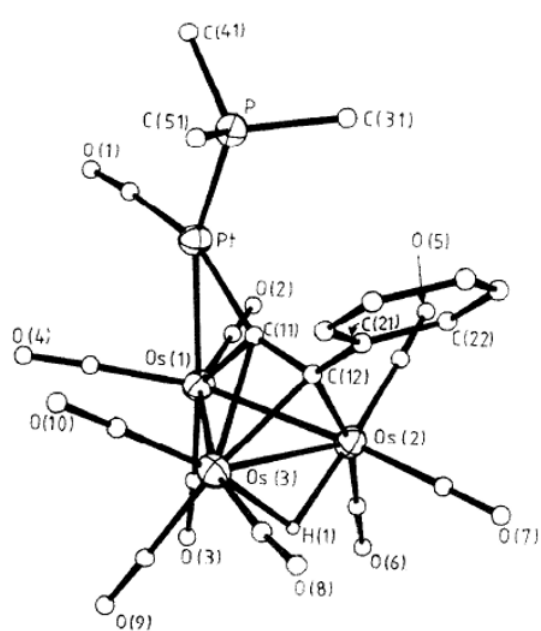
Figure 11. Structure of [(Pcy